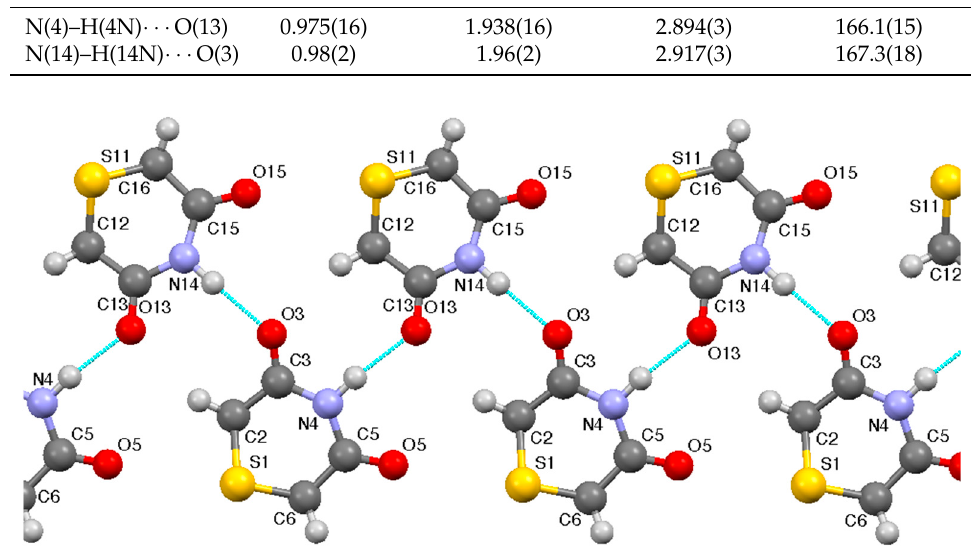
Figure 3. Hydrogen bonded ribbon in the structure of 1.